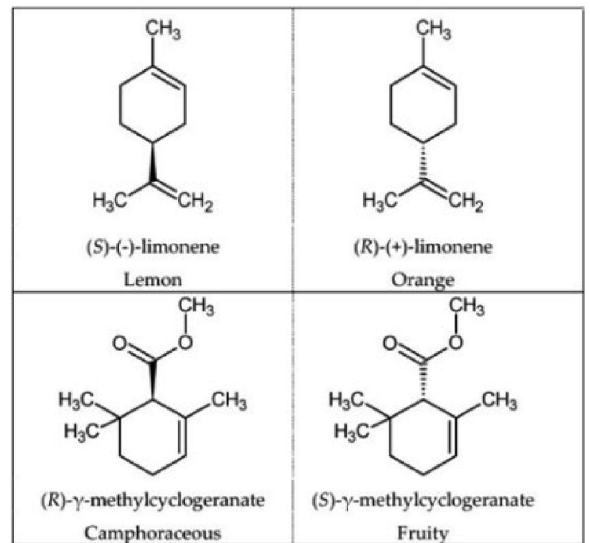
Figure 1 . Examples of enantiomeric compounds with dissimilar